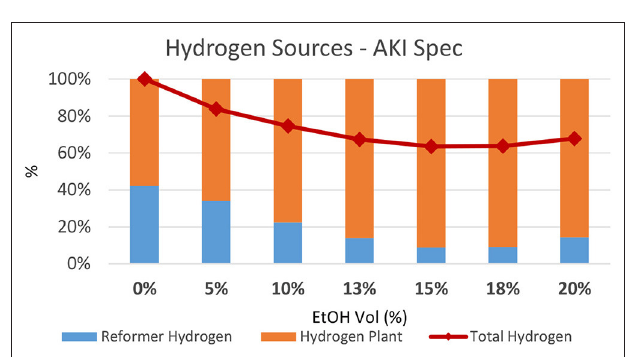
FIGURE 5 | Drop in reformer hydrogen with increasing use of low sulfur, high octane